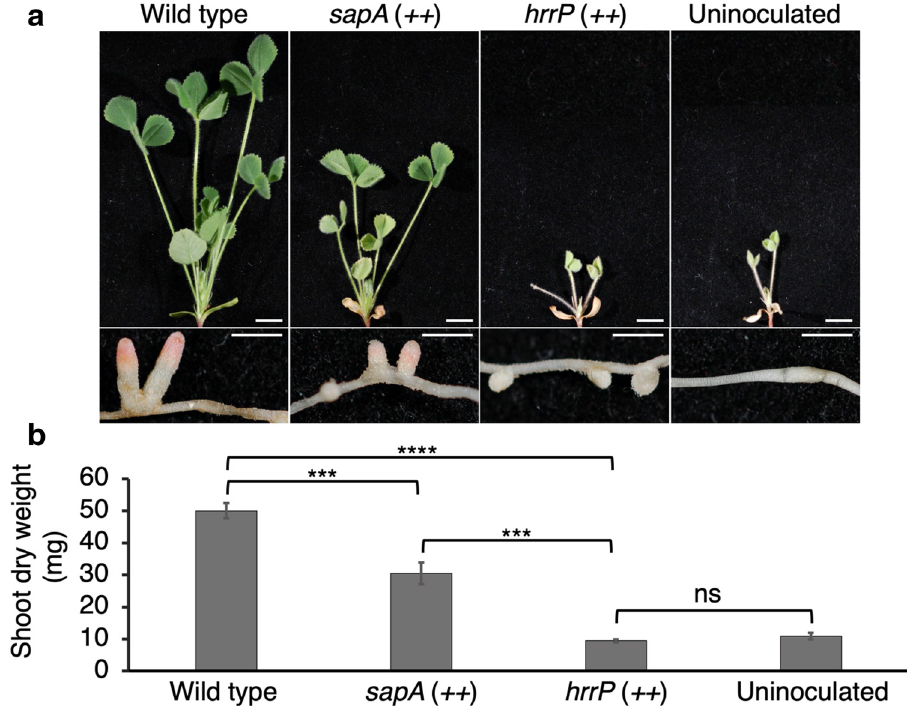
Figure 1. Effects of over-expressing peptidases on plant fitness. ( a ) Representative plants and nodules from each condition were harvested 28 dpi. Scale bars in shoot and nodule pictures are 1 cm and 0.25 cm, respectively. ( b ) Shoot dry mass was determined using the average masses of 12 plants of each condition harvested 28 dpi. For statistical analysis, a one-way ANOVA with a post-hoc Dunnett’s T3 test was performed. Significance levels are indicated (ns = not significant, *** P < 0.001, **** P < 0.0001). Standard error of the mean is represented in each bar.